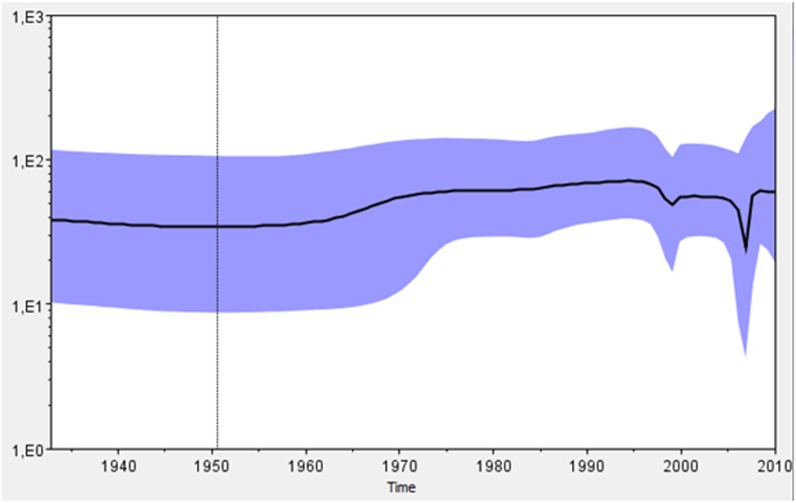
Bayesian skyline plot for DENV-1 genotype V.The population size of DENV-1 genotype V (Y axis) vs time in years (X axis) is shown. Ninety-percent highest probability densities are considered.